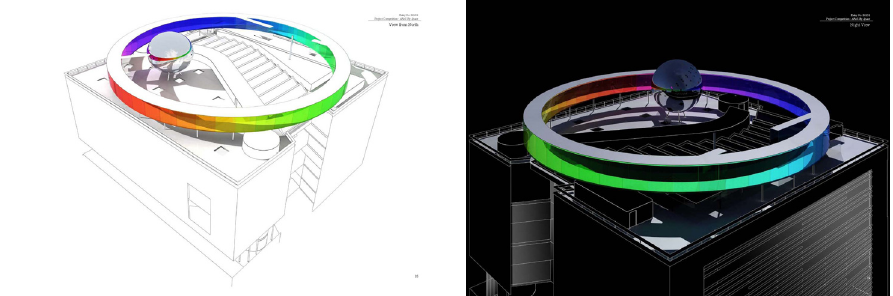
Figure 1: The ARoS Rainbow Panorama art object on top of the AroS art museum in Aarhus, daytime and nighttime